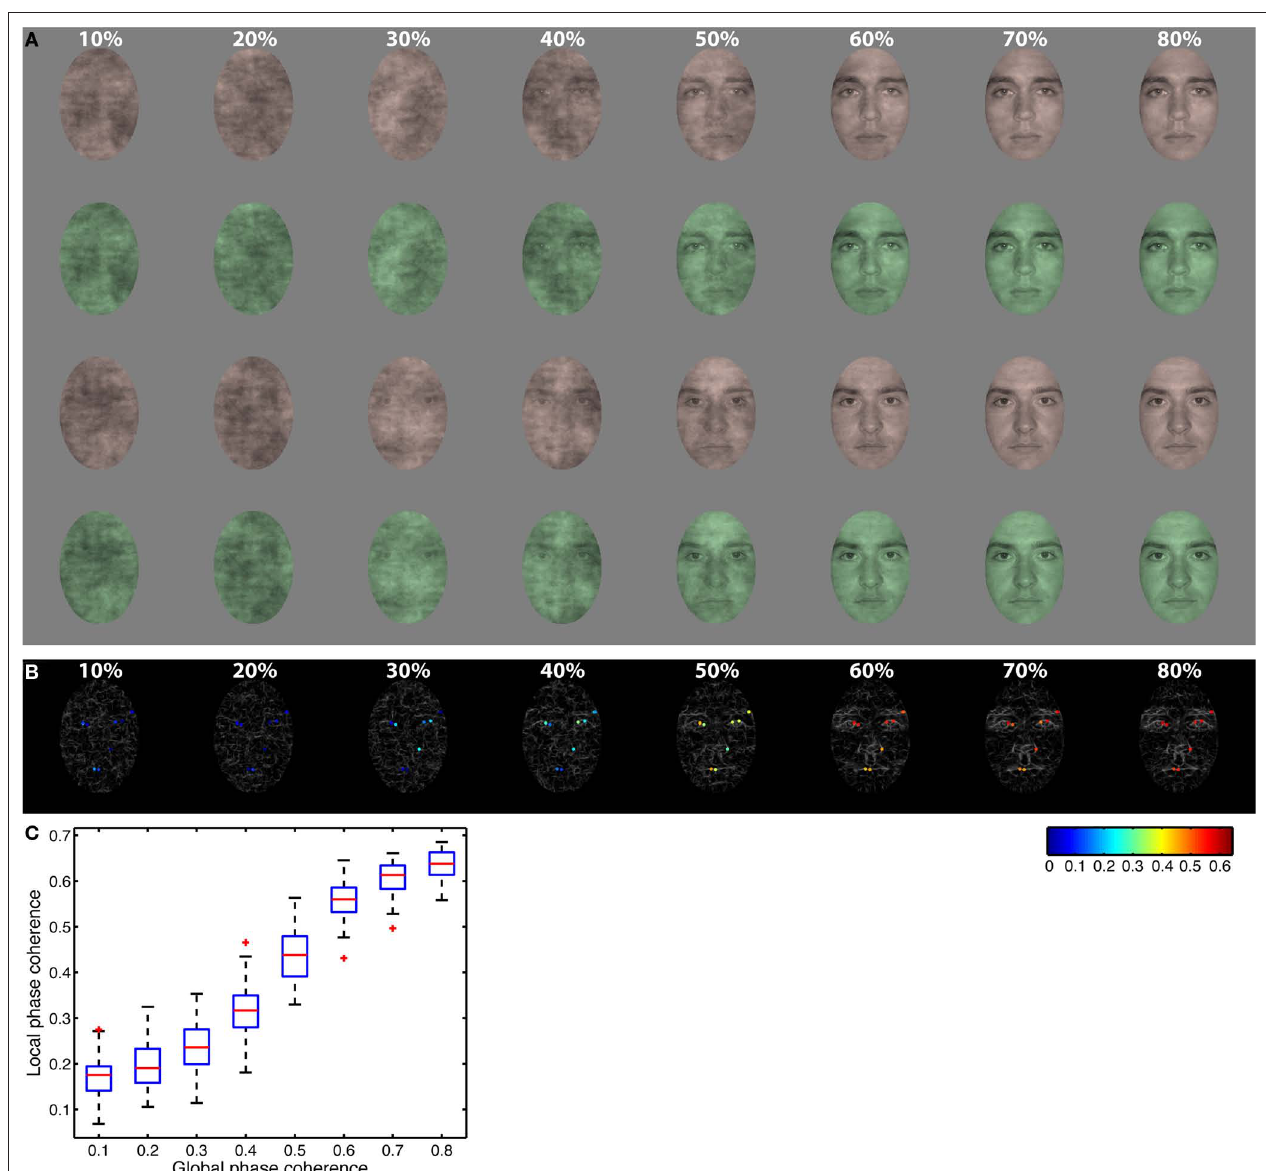
coherence is color coded at the 10 pixels with the highest local phase coherence. These 10 pixels were identified in the two original faces at 100% global phase coherence. Local phase coherence was maximal (red) at 80% global phase coherence, and approached zero (blue) at 10%. (C) Boxplots of local phase coherence at each level of global phase coherence for all the images seen by one subject. There is a non-linear relationship between the